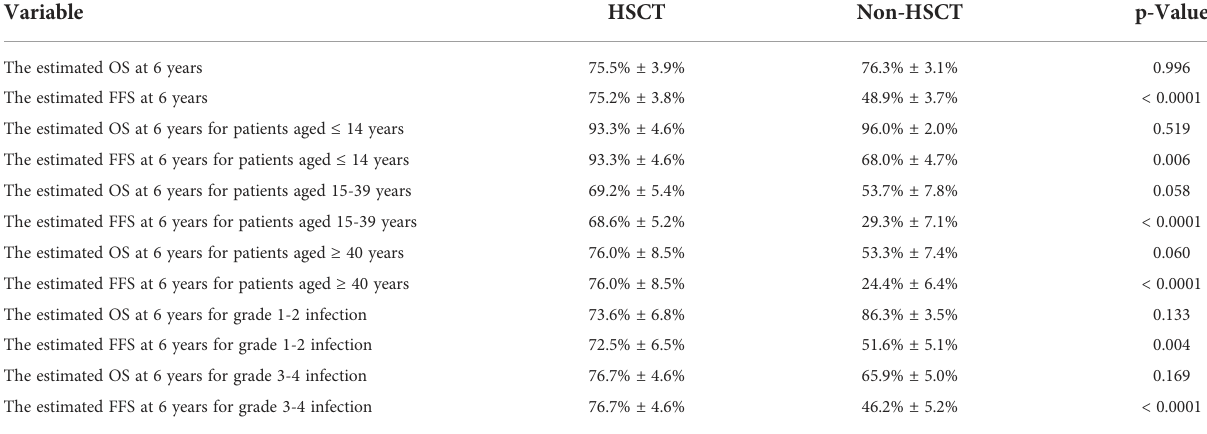
TABLE 3 OS and FFS of SAA patients in HSCT group and non-HSCT group.